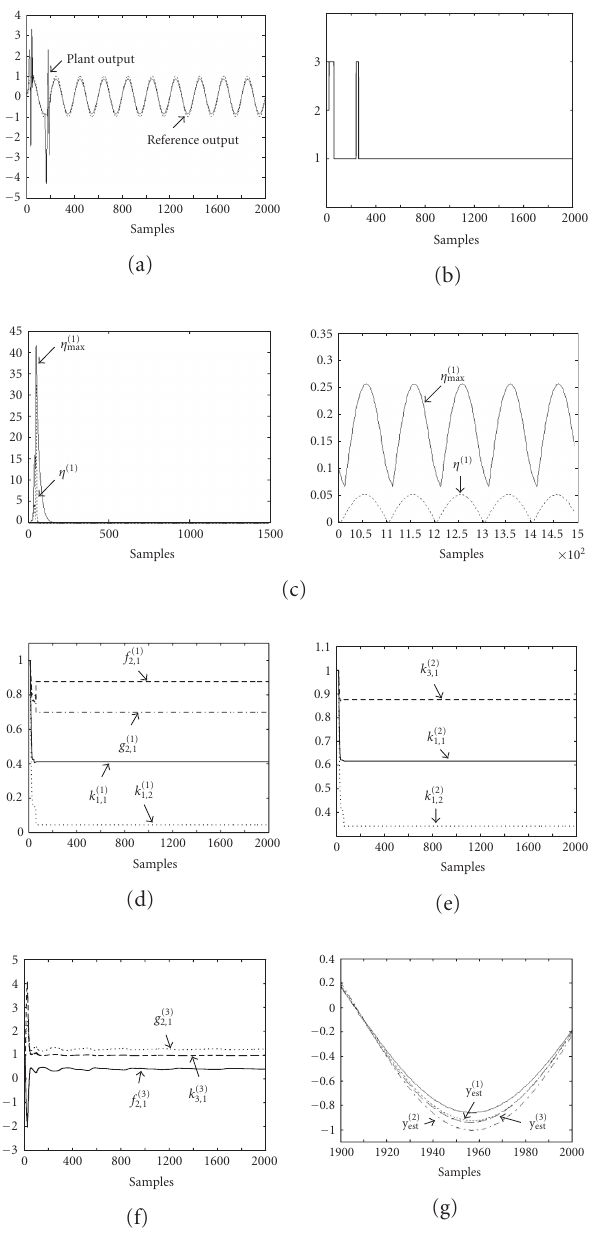
Figure 4.3. (a) Reference and plant outputs. (b) Active controller. (c) Contribution of the unmodeled part in the first model and the applied upper bounds. (d) Evolution of the estimates in model 1. (e) Evolution of the estimates in model 2. (f) Evolution of the estimates in model 3. (g) Estimated outputs for each